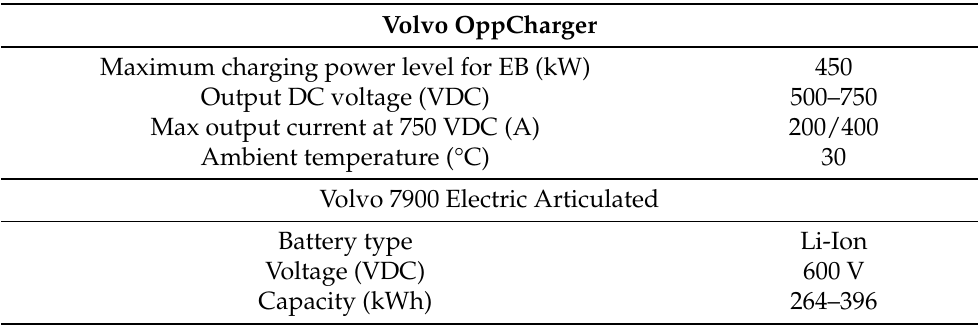
Table 4. Volvo Charger and EB